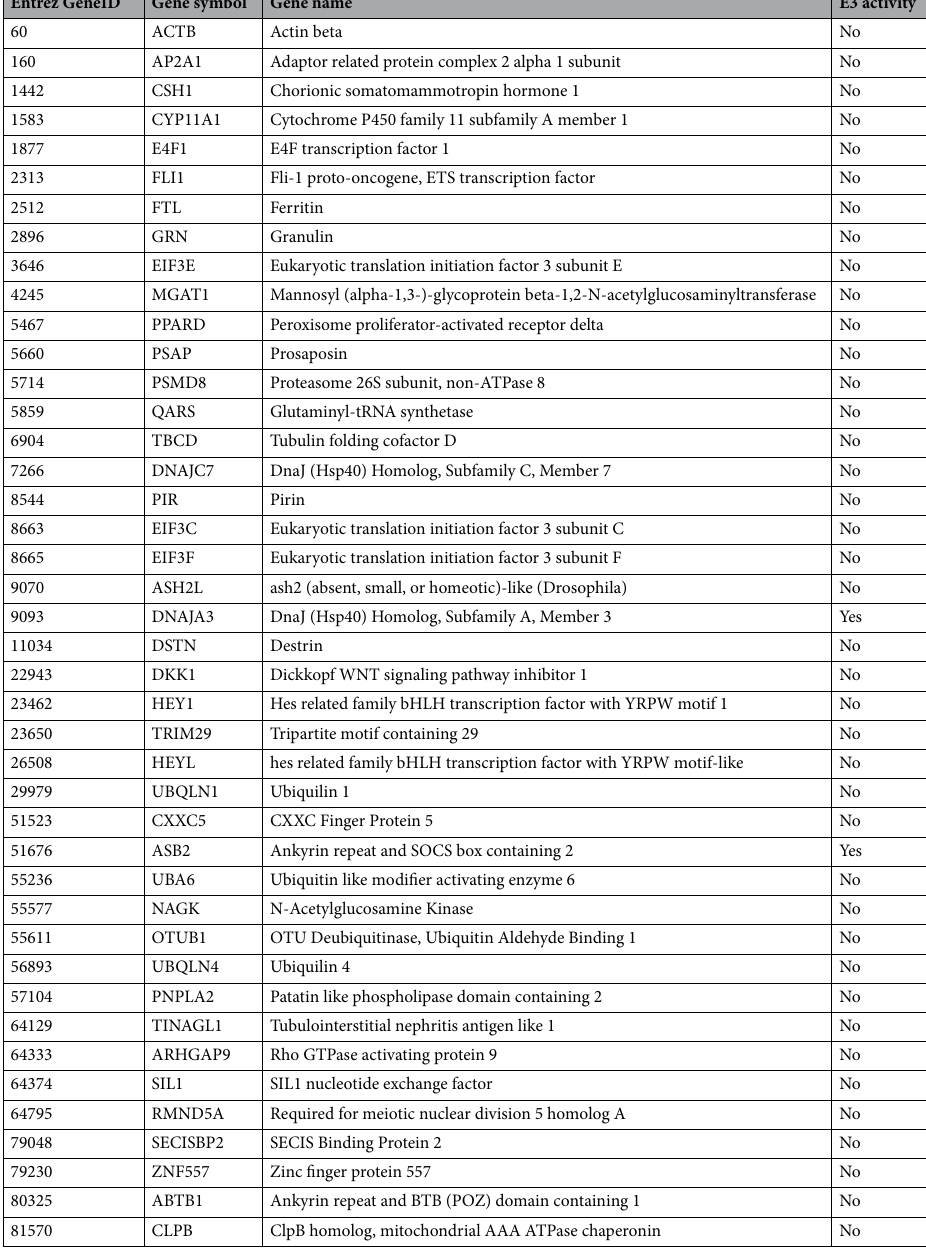
Table 1. Candidates of SMAD9 interacting proteins and their E3 activity. The potent interacting proteins of SMAD9 were narrowed down using 3 individual databases of interactome. MINT and BioGRID are common database of protein interaction provided on the web. Rual et al. provided human interactome database in the previously published study (see reference 19 ). The thorough literature search revealed that, among these candidates, only DNAJA3 and ASB2 have the E3